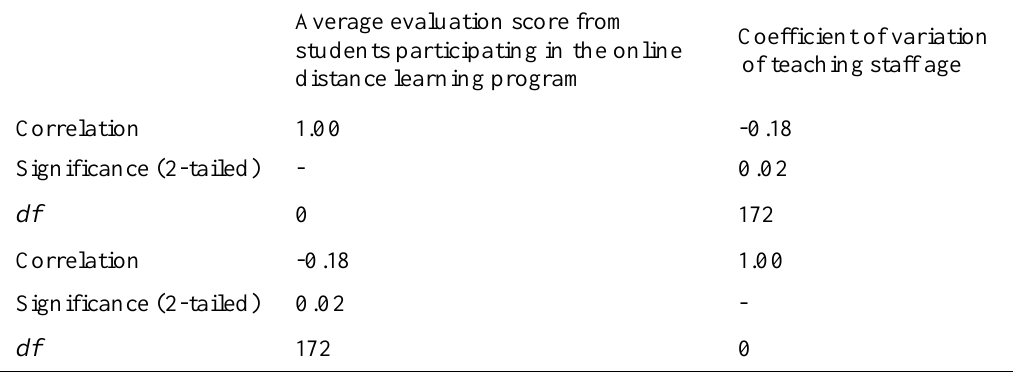
Correlation between Mean Evaluation Scores for Specific Online Courses and Disparity in Age among Teaching Staff Involved in these